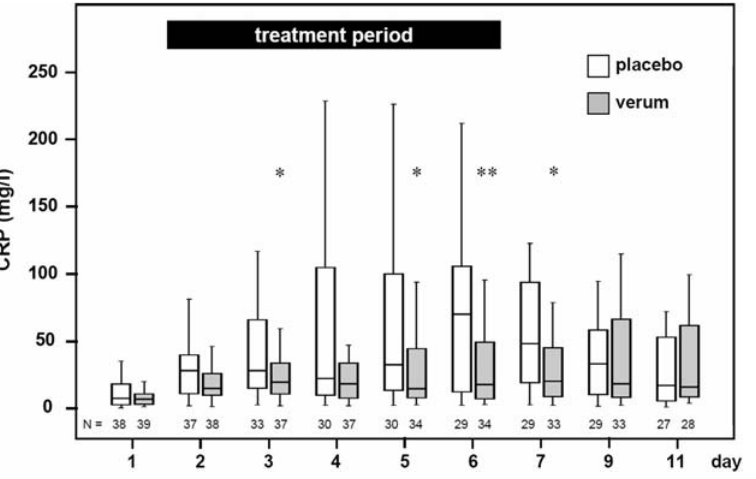
Figure 2. Time course of CRP serum concentration. Time course of CRP levels in placebo and verum group shown by boxplots. Number of patients is indicated by N. CRP levels in the moxifloxacin group are significant lower compared to the placebo group. The p-values for the main effects are , 0.0001 for day of CRP measurement and 0.0186 for treatment (multivariate analysis of variance for repeated measurements on logarithmically transformed data, no interaction model). The dependency between treatment and day of CRP measurement has a p-value of 0.0845 (interaction model). In patients of the verum group CRP concentration are significantly lower compared to patients of the placebo group 3, 5, 6, and 7 days after stroke (* p , 0.05; ** p , 0.005).